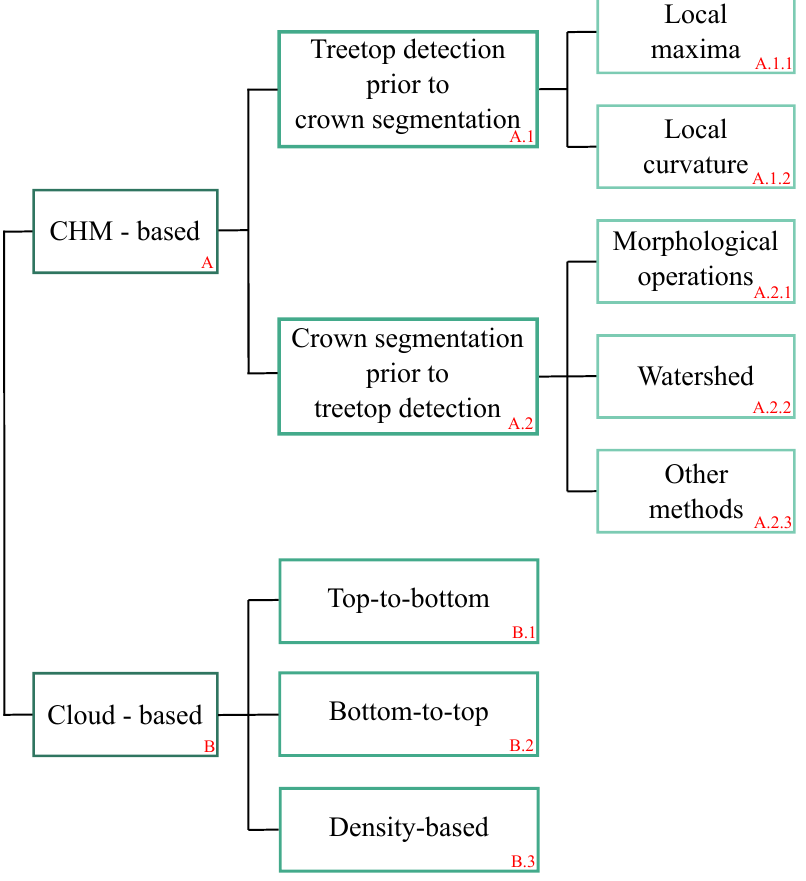
Figure 1. Classification of the methods that have been proposed so far to identify individual trees. The numbers in red correspond with the labels associated with the classification of the literature works shown in Table S1 of the Supplementary